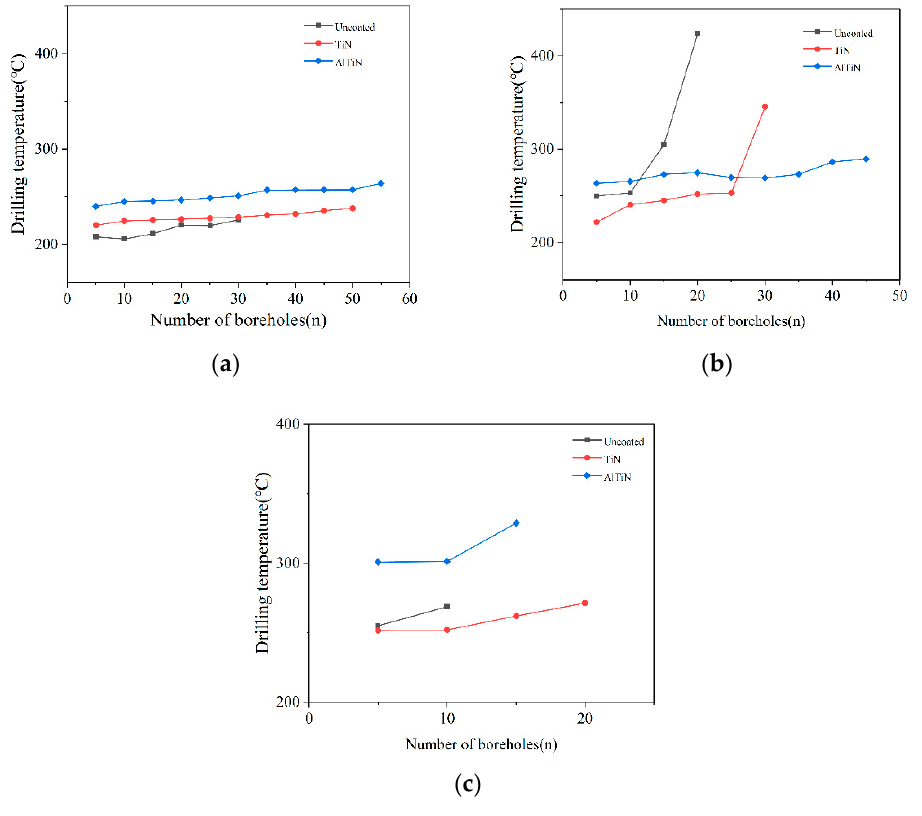
Figure 6. Drilling temperature curve (Feed speed of 0.04 mm/r). ( a ) Drilling speed of 15 m/min. ( b ) Drilling speed of 20 m/min. ( c ) Drilling speed of 25 m/min.